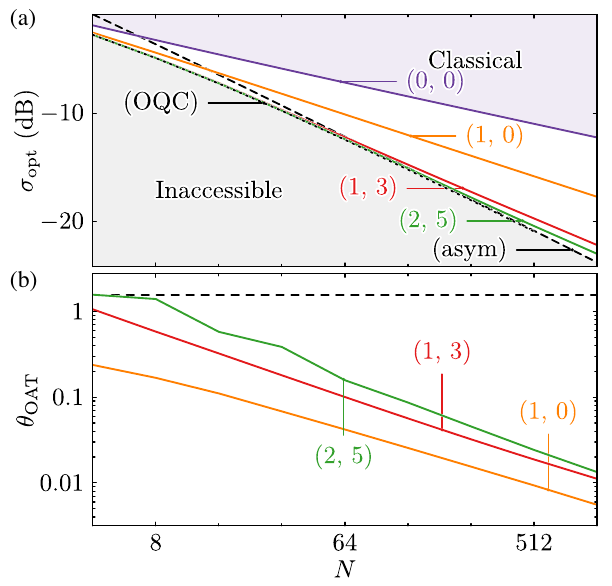
FIG. 13. (a) Recalculation of the particle number dependence of the dimensionless Allan deviation in Fig. 11 for constrained interaction angles. (b) The cumulative angle of all one-axis- twisting gates T required to obtain the dimensionless Allan x;y deviations displayed above. The vertical dashed line indicates the interaction angle of π = 2 required to prepare a GHZ sequences can also work with a cumulative interaction that decrease rapidly with N while the resulting Allan deviation remains a good approximation of the unconstrained opti- mization in Fig. 11.